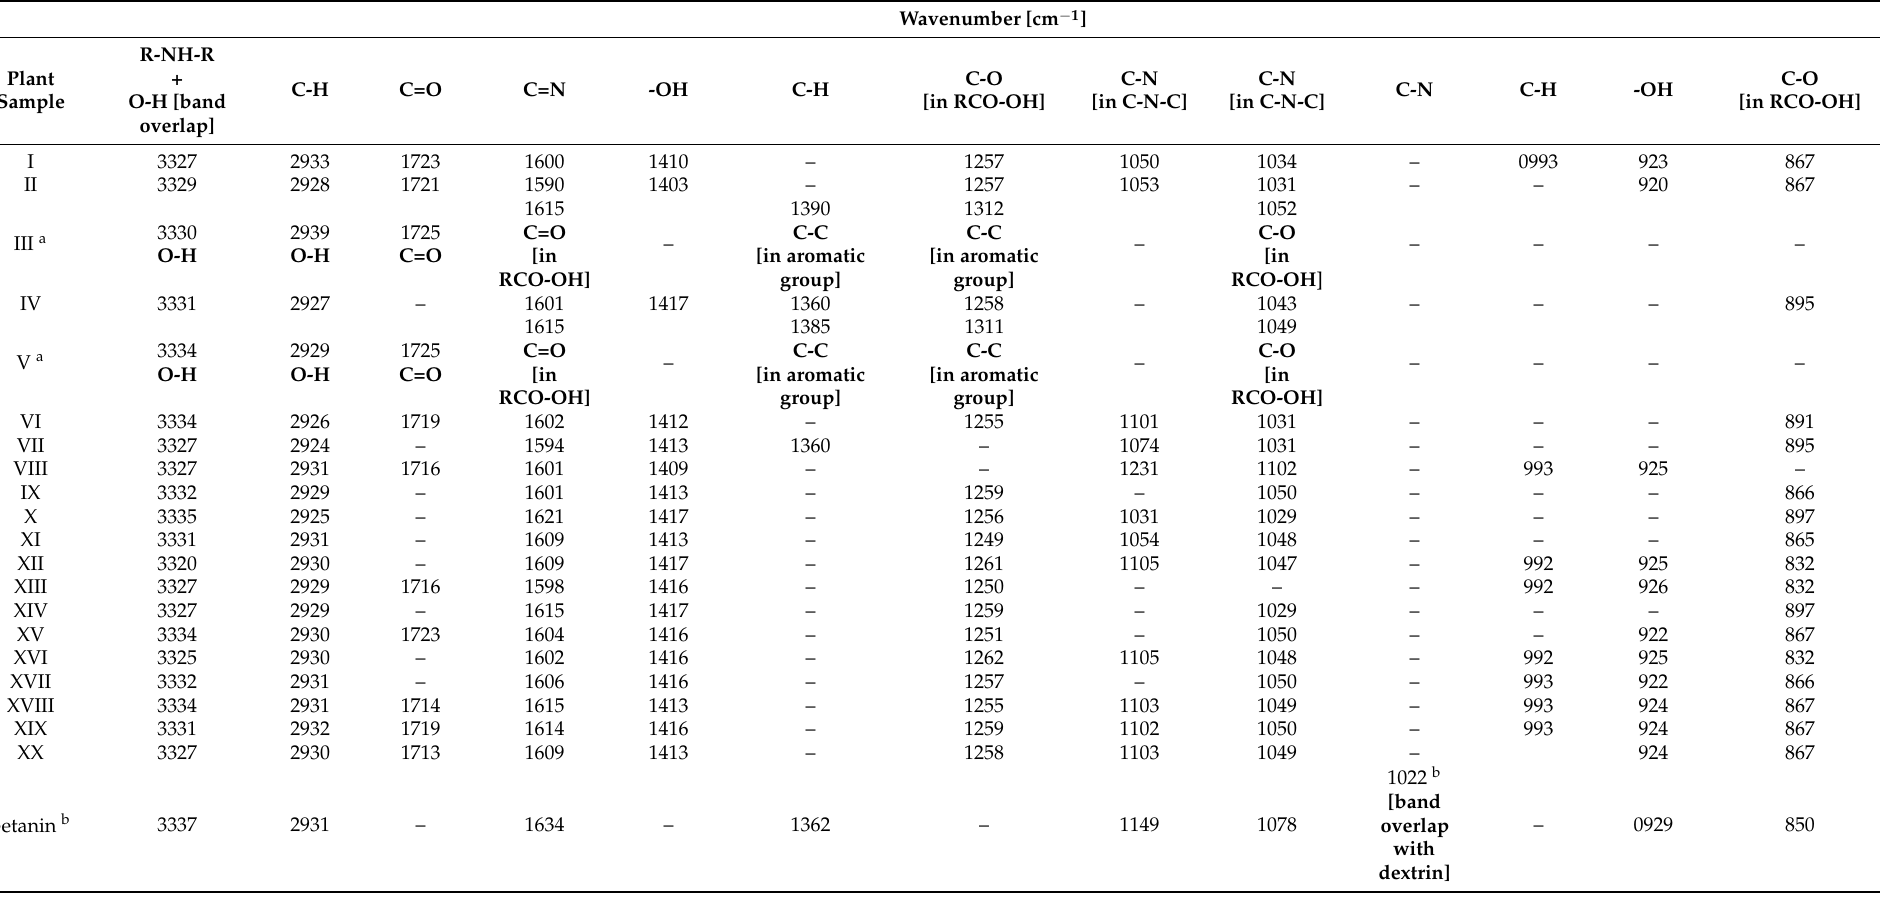
Table 4. FTIR spectral analysis of dry methanolic Epiphyllum , Hylocereus , and Opuntia fruits